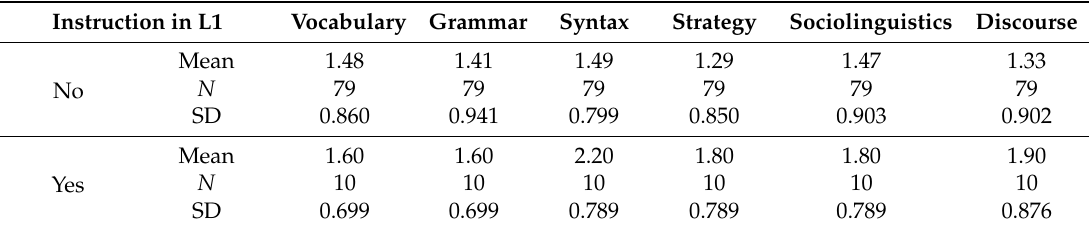
Table 5. Analysis of performance considering L1 parallel